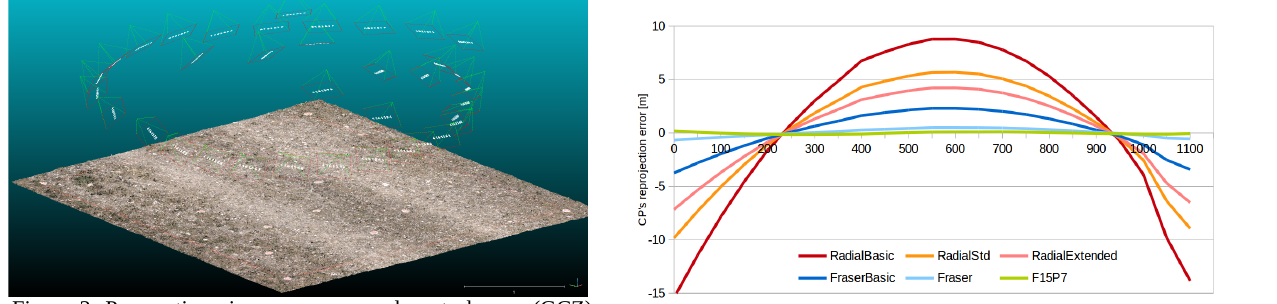
Figure 2: Perspective view over a ground control zone (GCZ) and the 35 images acquired to produce it La Palliere's dyke is a structure subject to a reinforced monitoring. Visual surveillance, combined to topographic leveling and piezometric measurements are deployed to monitor a subsidence zone. The 1200 meters long structure has been used as a test site, on which two acquisitions have been conducted, in 2014 (only 600 meters long) and 2015 with a nine months interval between each. Each dataset is made of an Unmanned Aerial Vehicle (UAV) acquisition, 45 GCP and 10 Ground Control Zones (GCZ), both evenly distributed along the profile. A GCZ is a roughly 2x2 meters rectangular area, delimited by 5 GCP, and on which terrestrial images have been acquired to produce a millimeter accurate ground truth.